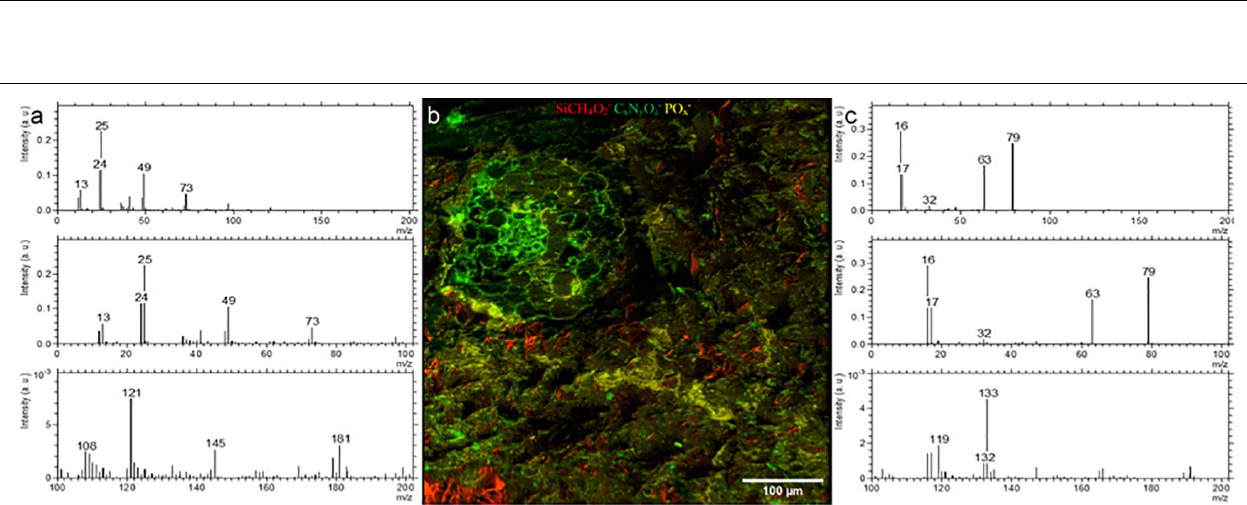
FIGURE 3 | Resulted disk of soil column after water-jet cutting. Disk is a stitched image from 2704 individual images at darkfield microscopy mode. Insets 1-2 shows the magnified RoI marked in the soil disk. Crosses are surface features used to identify the RoI under different microscopes. (2) Epi-fluorescence micrograph of RoI showing the root, soil and minerals. Square marked in yellow is the RoI for high-resolution microscopy under HIM, ToF-SIMS, SEM-EDX, nanoSIMS and µ -Raman.